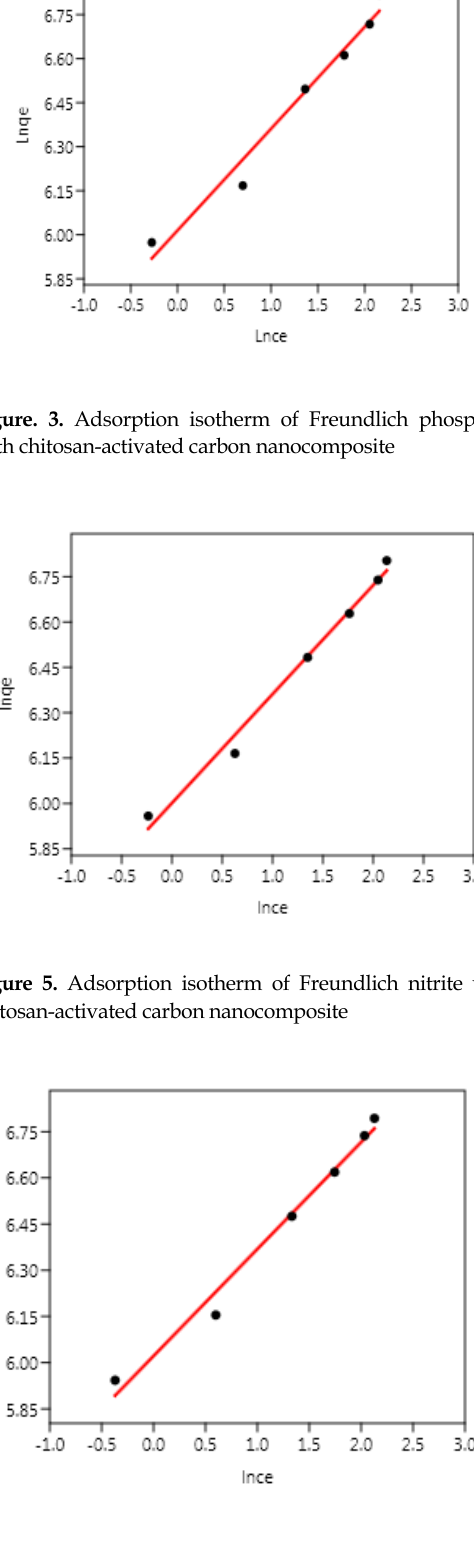
Figure 7. Adsorption isotherm of Freundlich ammonia with chitosan-activated carbon nanocomposite